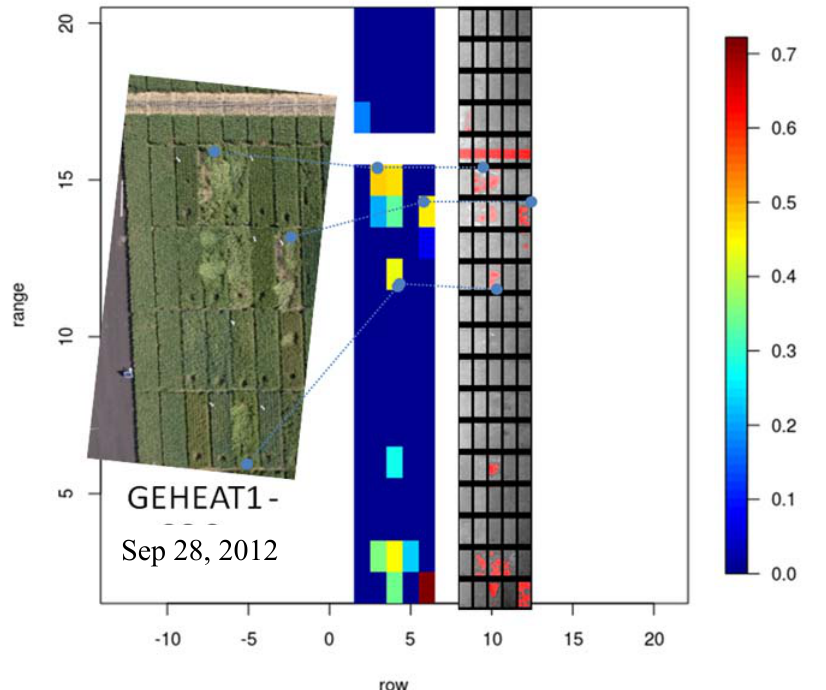
Figure 8. Spatial layout (range and row) of a wheat variety trial showing the proportion of lodging (zero to one, coloured) by area for each plot. The proportion of lodging was estimated as the proportion of pixels within each plot that were deemed to be lodged. The right-hand false-colour image of crop height estimated from the DEM (Figure 8) shows the pixels (red) that had been deemed to be lodged based on their (low) estimated height within plots that had extreme variance. A single visual image of the upper part of the trial ( left ) is shown for comparison to the quantitative analysis, with example plots, from an irrigated wheat trial designated as 12GEHEAT-1, linked by blue lines across the three